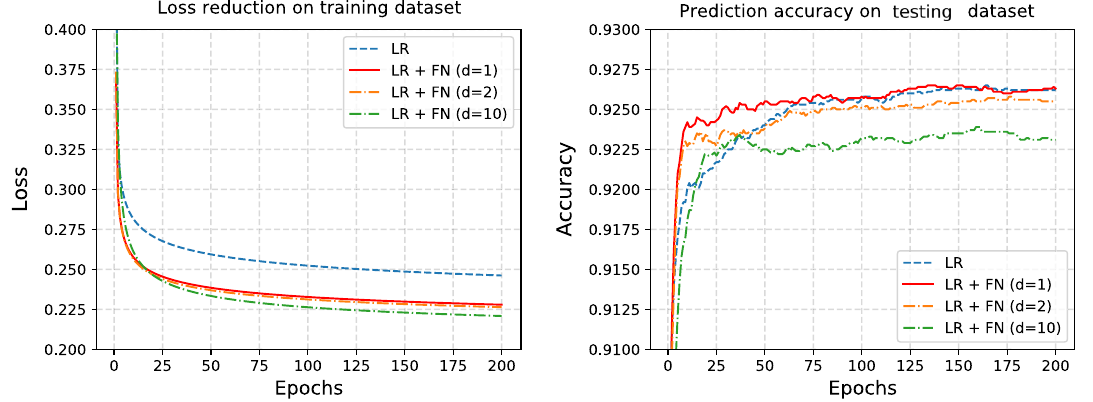
Figure 2. LR stands for logistic regression and FN stands for factor normalization. The left panel shows the training loss of the logistic regression model and FN model optimized by SGD on MNIST images. The right panel shows the prediction accuracy on the testing dataset. Different numbers of factors are considered (i.e., d = 1, 2, 10 baseline and FN models. Detailed results are presented in Fig. 2. For comparison purposes, all models are trained for many epochs so that their performance on the testing data is fully converged. Specifically, a batch size of 200 with 200 epochs is adopted and we use constant learning rate 0.05 during training process. The left panel of Fig. 2 shows the training loss for the various models. We find that the FN models consistently outperform their bench-